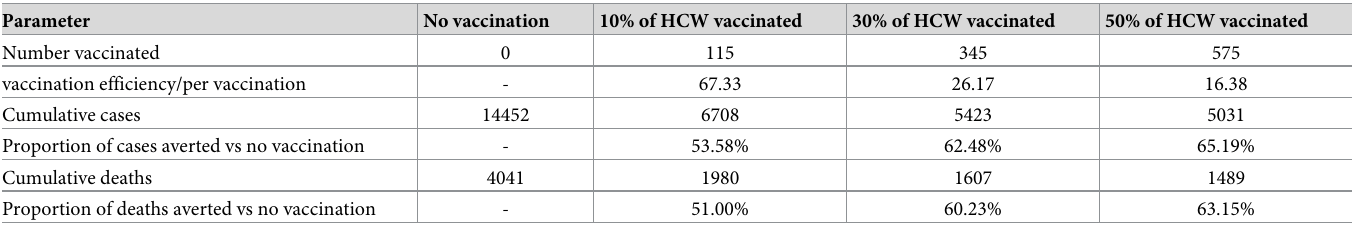
Table 4. Impact of vaccination for healthcare workers on cumulative cases and deaths among overall population caused by